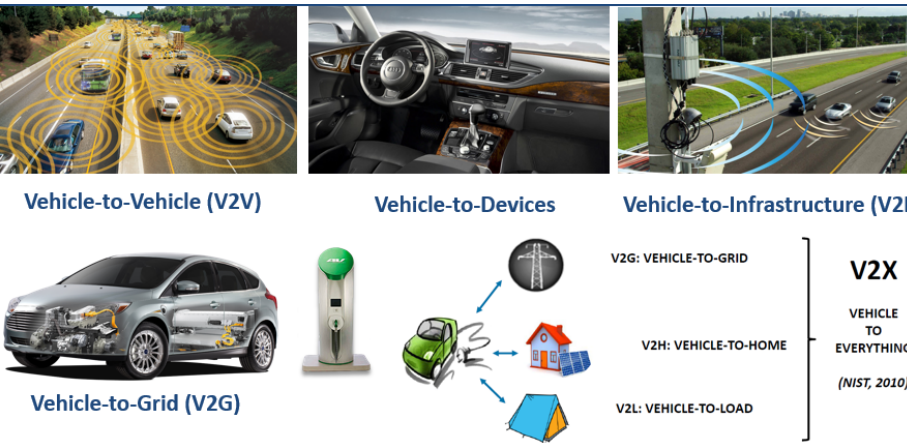
Figure 3. Different interaction modes of electric vehicles [18] . Figure 3. Di ff erent interaction modes of electric vehicles